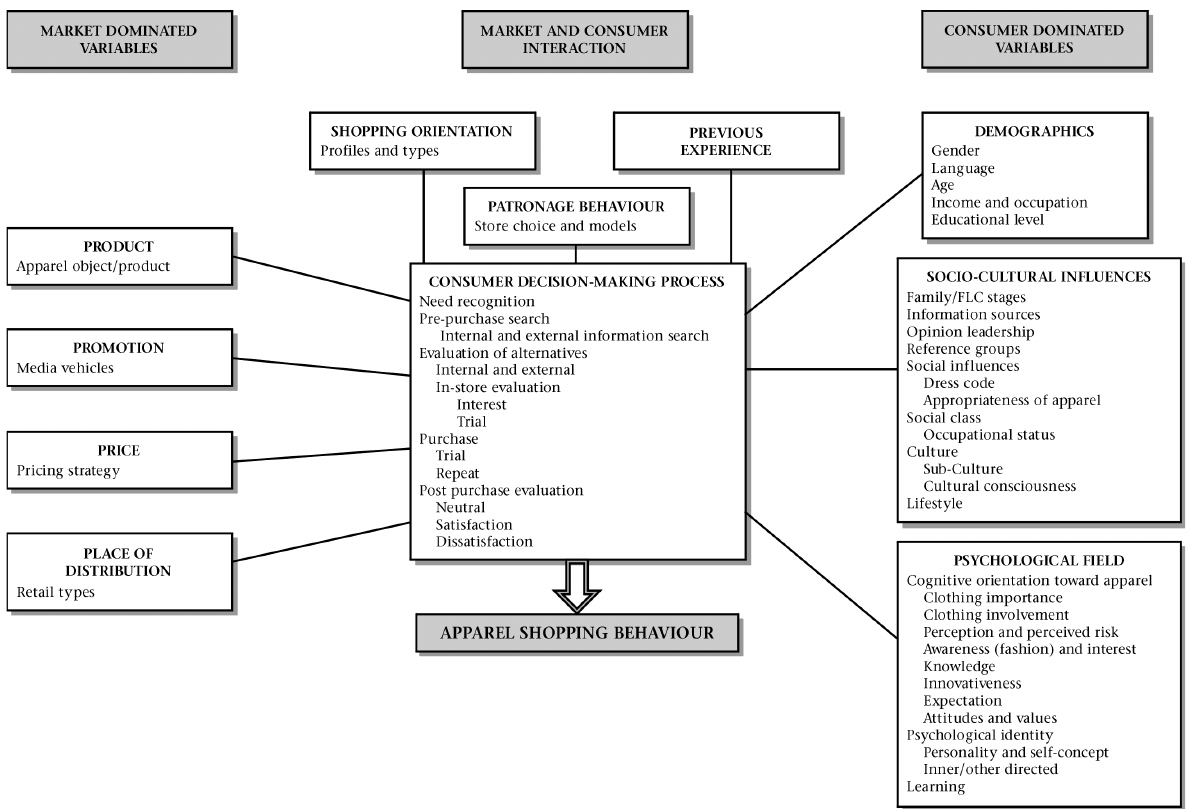
Figure 1: Conceptual theoretical model: a macro-perspective of variables influencing apparel shopping